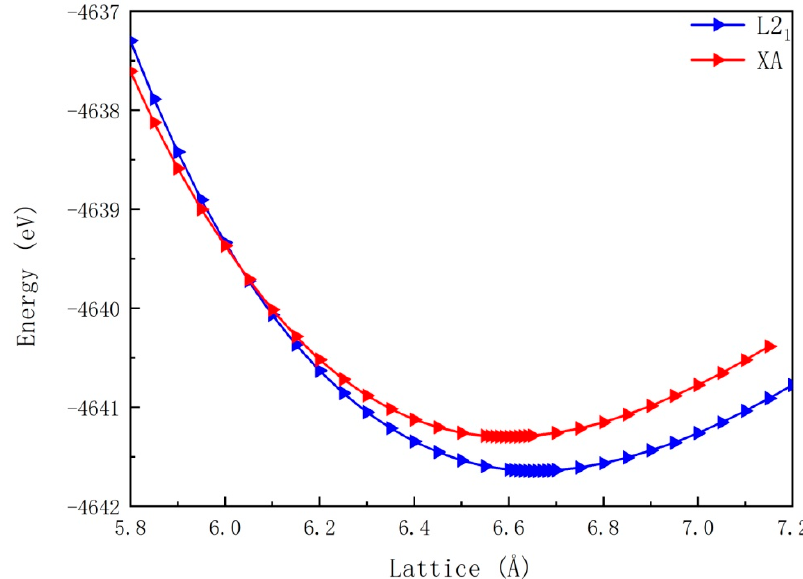
Figure 1. Crystal structures of XA and L2 1 -type for Sc 2 VGe compound.